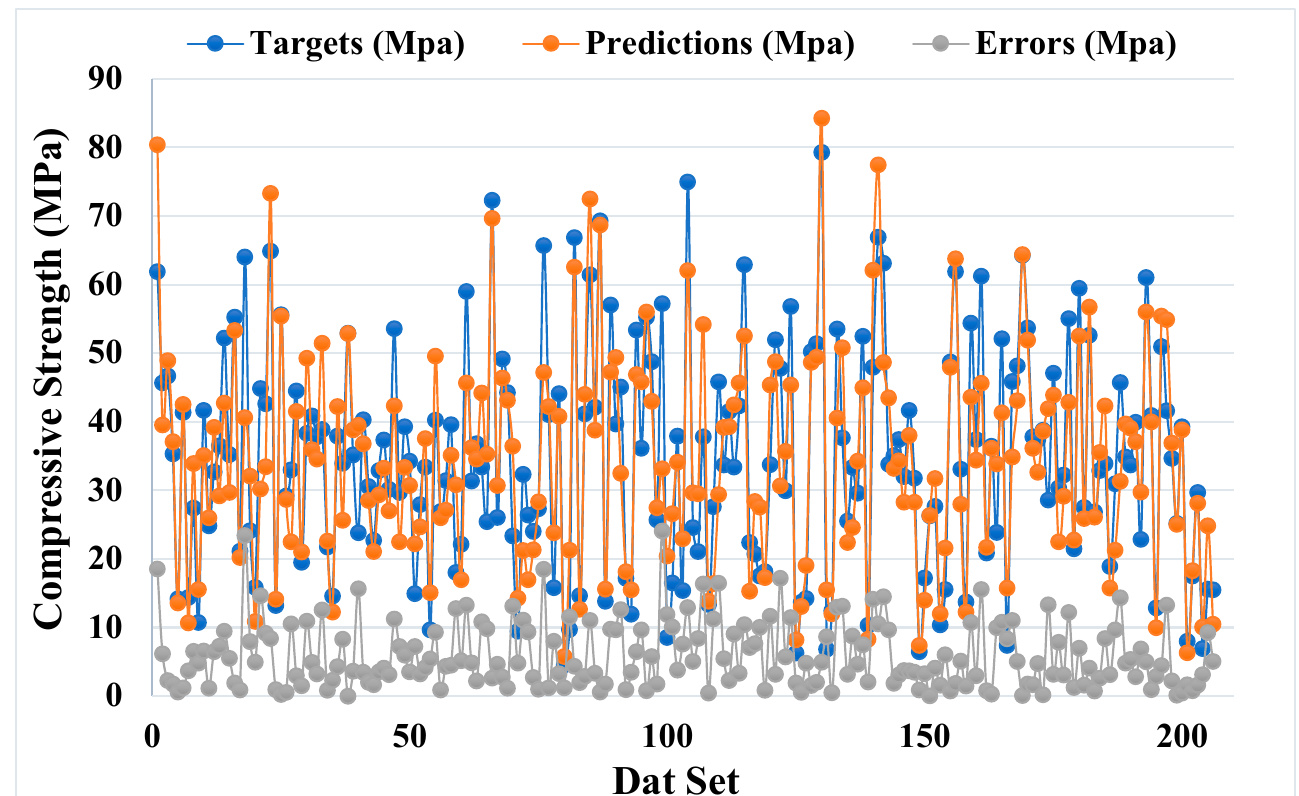
Figure 10. Distribution of actual and predicted values along with the errors for the DT model.